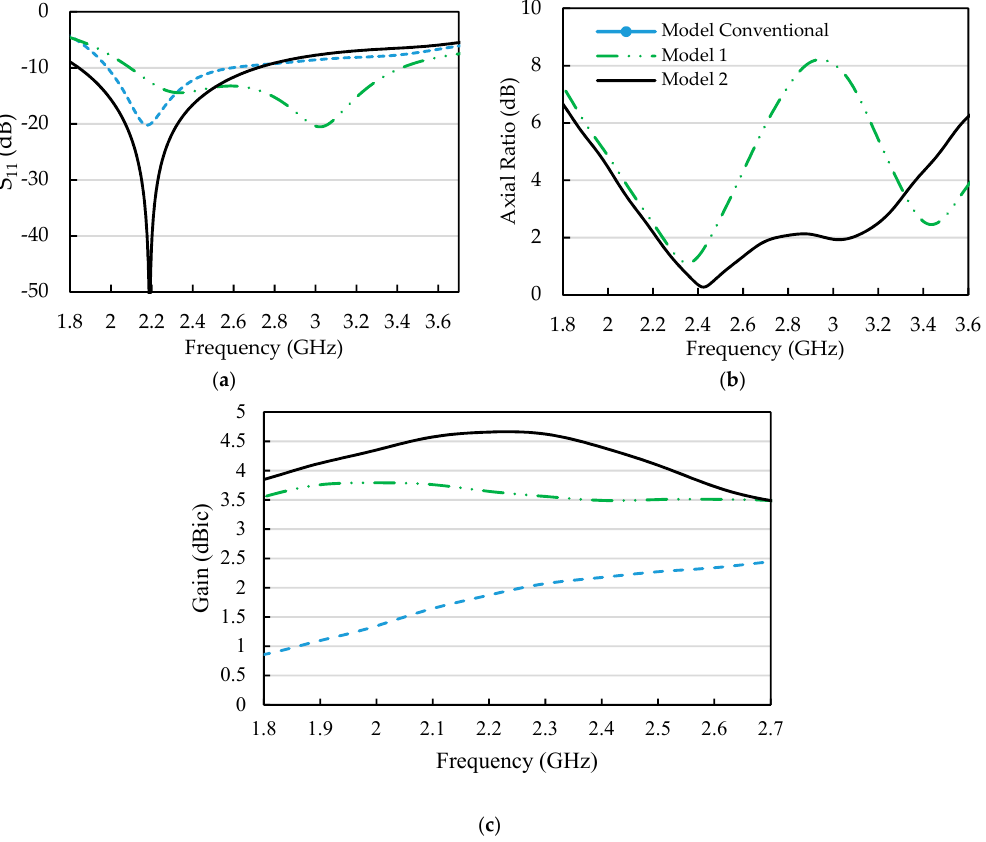
Figure 5. Comparison of the conventional model, model 1, and model 2: ( a ) S 11 , ( b ) axial ratio, and ( c ) antenna gains.